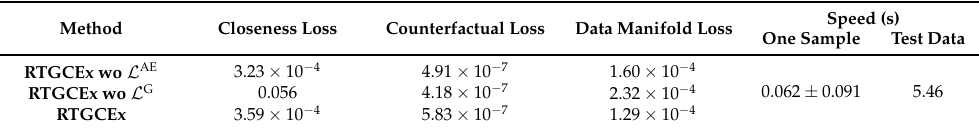
Table 5. Mean values obtained for each loss function in test data using the three variations of the losses optimized in